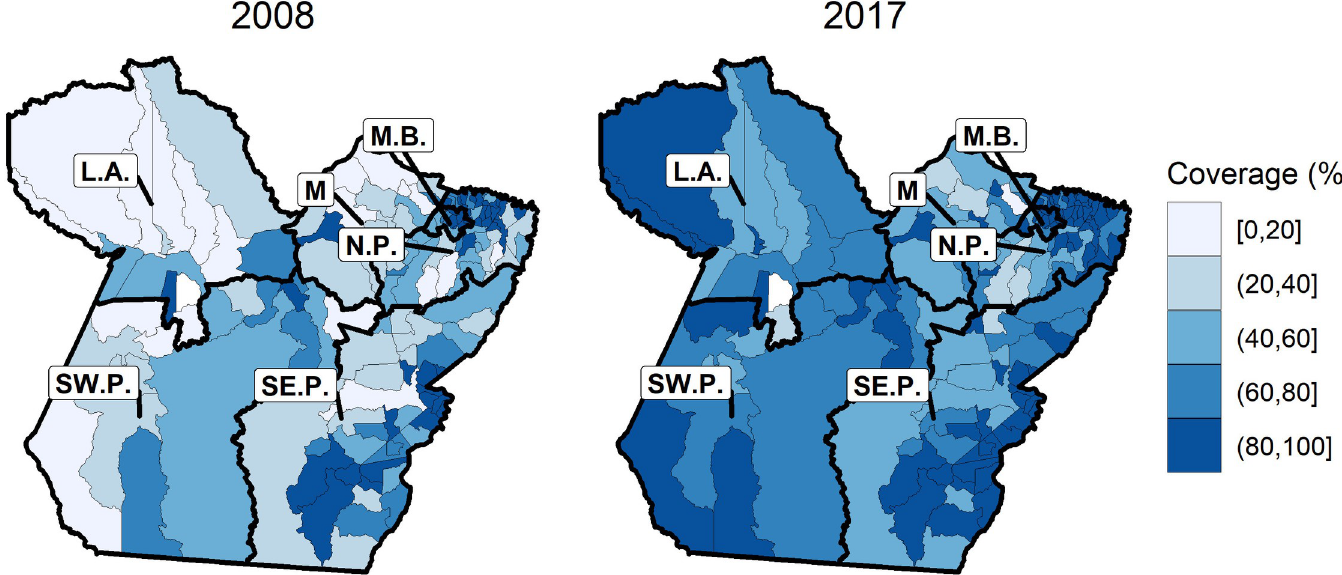
Fig 1. Primary care coverage in the state of Para´, 2008–2017. Municipal distribution of the typology considering the expansion of health coverage in the municipalities of the State of Para´, the lighter colors represent lower coverage and the darker colors mean an increase in health coverage. Source: Own elaboration on maps by Brazilian Institute of Geography and Statistics